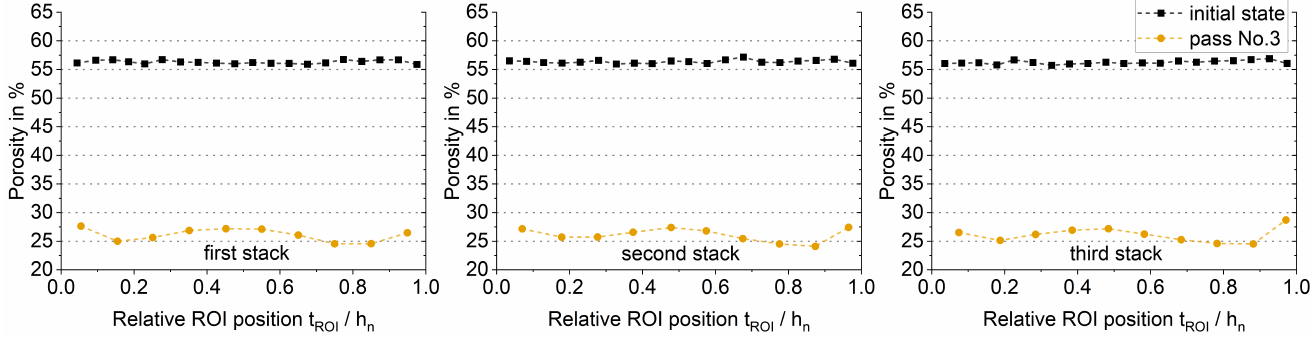
Figure A8. Series II: 20-0.50-3 ( l d / h m ≈ 1.2 − 1.4): Porosity change over relative sample depth (0=upper surface; 0.5= mid-section of sample; 1=lower surface) due to rolling for first, second and third stack.